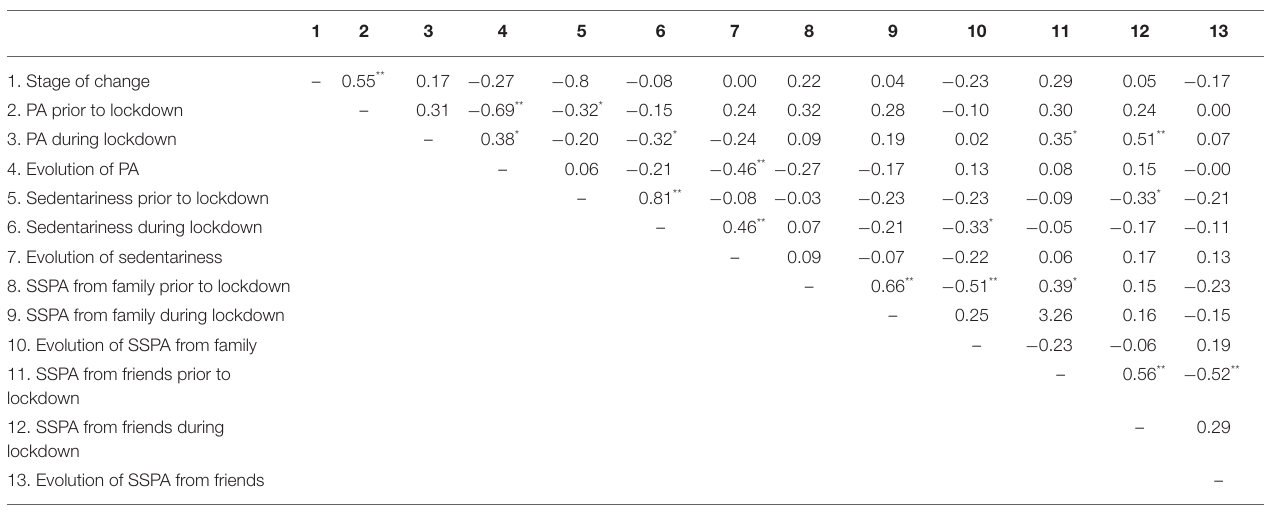
TABLE 3 | Bivariate Correlations for Students ( n = 38).